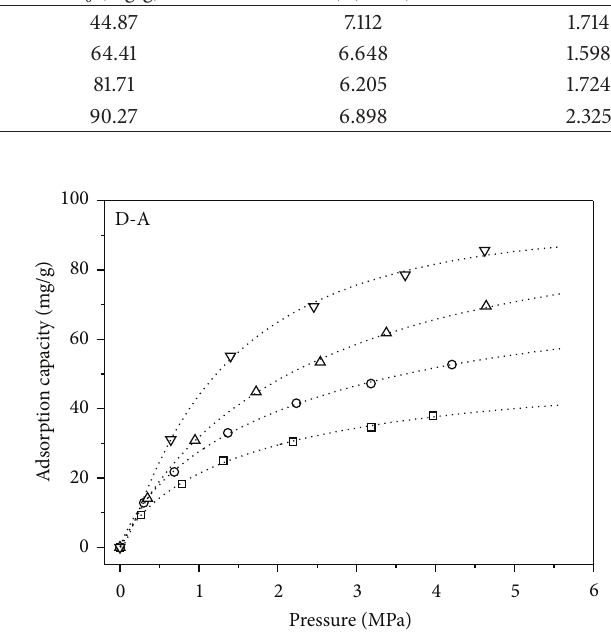
Figure 6: Equilibrium isotherms of methane adsorption on carbon spheres at 298 K. ◻ : CS0; I : CS3; △ : CS6; 󳶚 : CS9; and dotted line: Langmuir model.